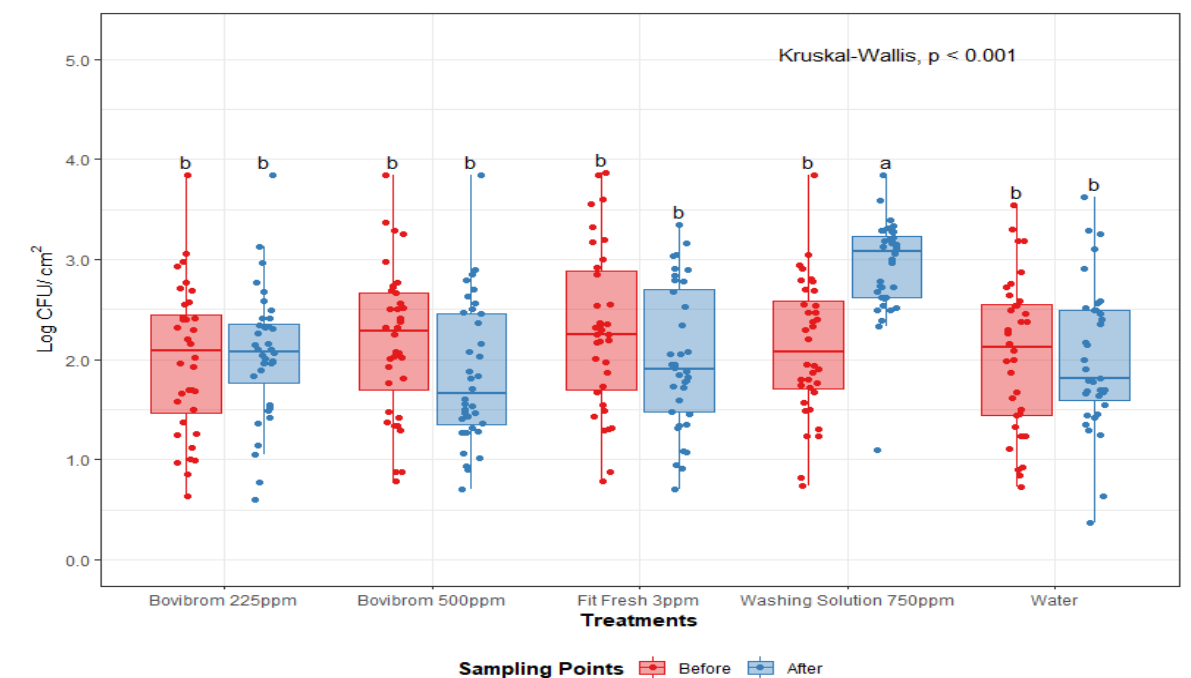
Figure 2. Psychrotrophic aerobic plate counts (Log CFU/cm 2 ) before and after treatment application on pork loin sections ( n = 36 per treatment). In each boxplot, the horizontal line crossing the box represents the median, the bottom and top of the box are the lower and upper quartiles, the vertical top line represents the upper interquartile range, and the vertical bottom line represents the lower interquartile range. Boxes with different letters a,b are significantly different according to Kruskal–Wallis analysis followed by pairwise comparison Wilcoxon’s test at p < 0.05. The points represent the actual data points. Active ingredients: Bovibrom = 1,3-Dibromo-5,5-dimenthylhydantoin; Fit Fresh = chlorine dioxide; Washing Solution = rhamnolipid.